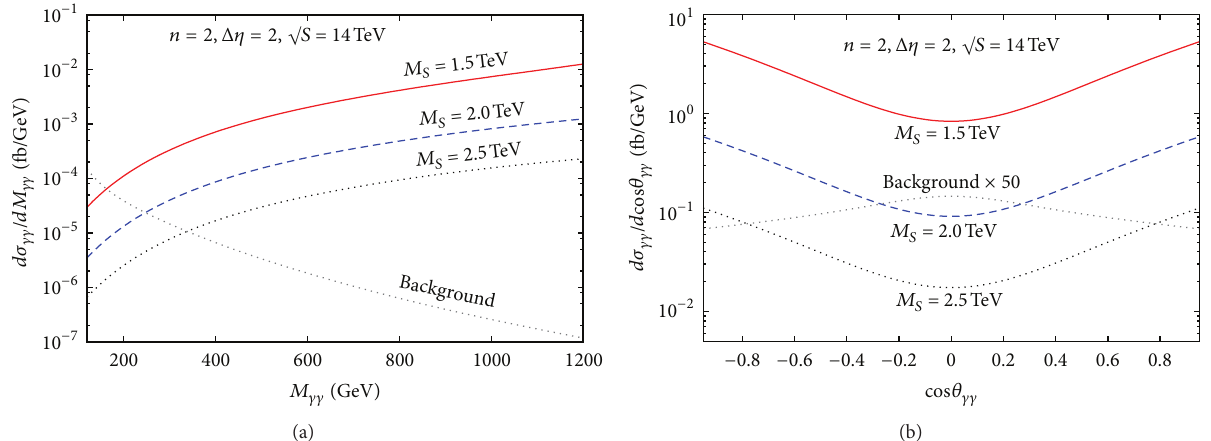
Figure 12: (a) The invariant mass distributions ( 𝑑𝜎 𝛾𝛾 /𝑑𝑀 𝛾𝛾 ) for signal and background ( 𝑝𝑝 → 𝑋+𝛾𝛾+𝑌 ) of the photon pair after applying the cuts defined in (18) at the 14TeV LHC. (b) The angular distributions ( 𝑑𝜎 𝛾𝛾 /𝑑 cos 𝜃 𝛾𝛾 ) for signal and background after applying the cuts defined in (19) at the 14TeV LHC. For both plots, we take 𝑀 𝑆 = 1.5, 2.0, and 2.5 TeV and 𝑛 = 2 for signal and Δ𝜂 = 2 for both signal and background. The background in (b) is shown after multiplying by a factor of